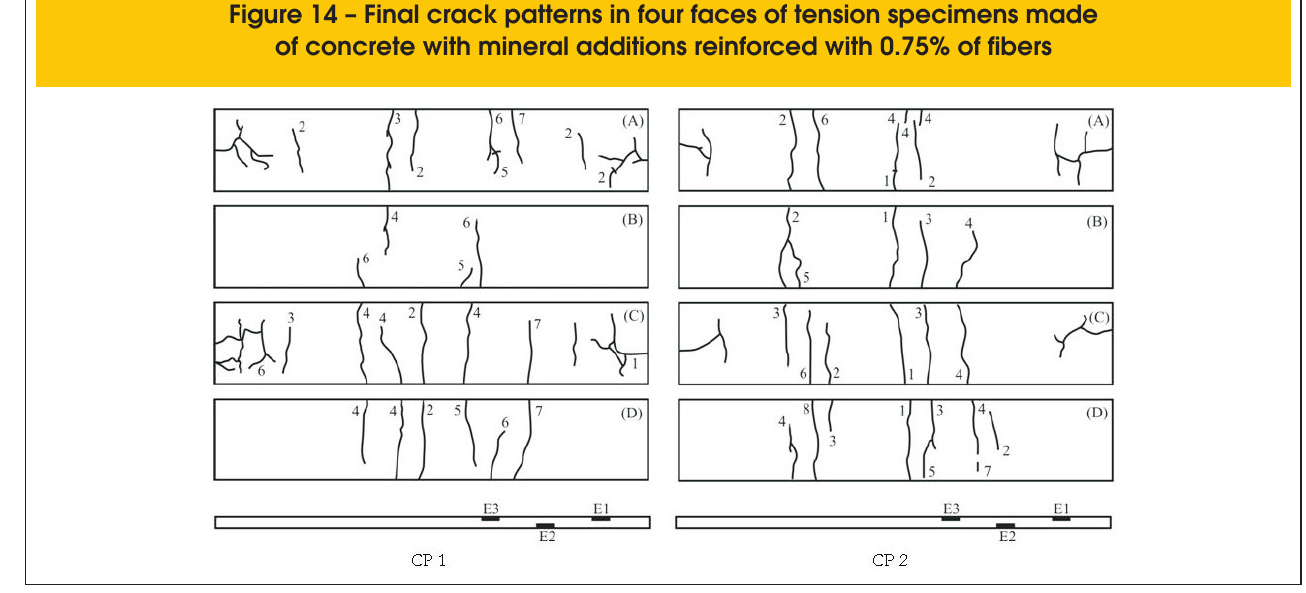
Figure 14 – Final crack patterns in four faces of tension specimens made of concrete with mineral additions reinforced with 0.75% of